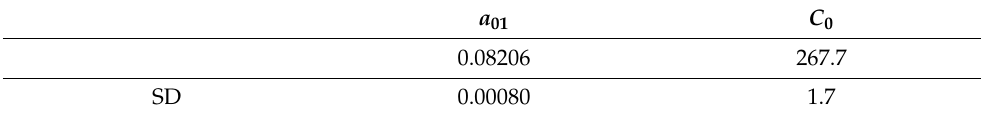
Figure 5. Residual enthalpy for starting point model ( a ) and after generalization ( b ). Table 3. The coefficients for Equation (5) for heating in the form of a Heaviside function.